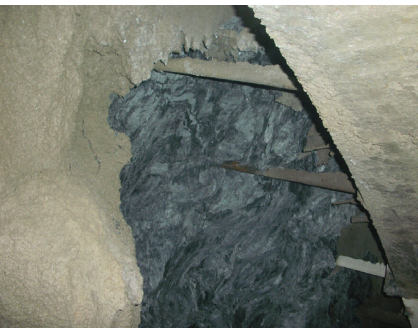
Figure 1: Sericite phyllite. Table 1: Similarity ratios of test parameters.